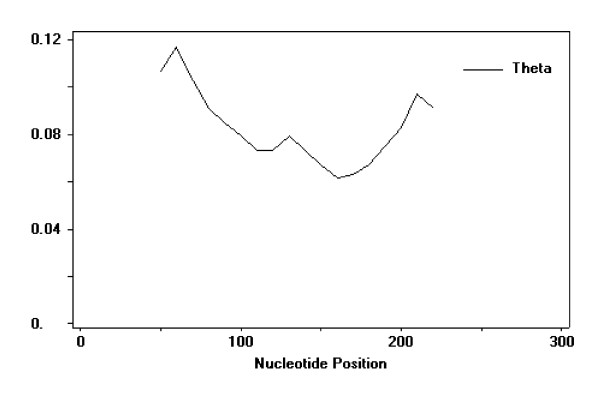
The nucleotide diversity within exon2 sequences of MHC IIB genes at the 88 alleles denoted by Theta-W. Sliding window length: 100; step size: 10.